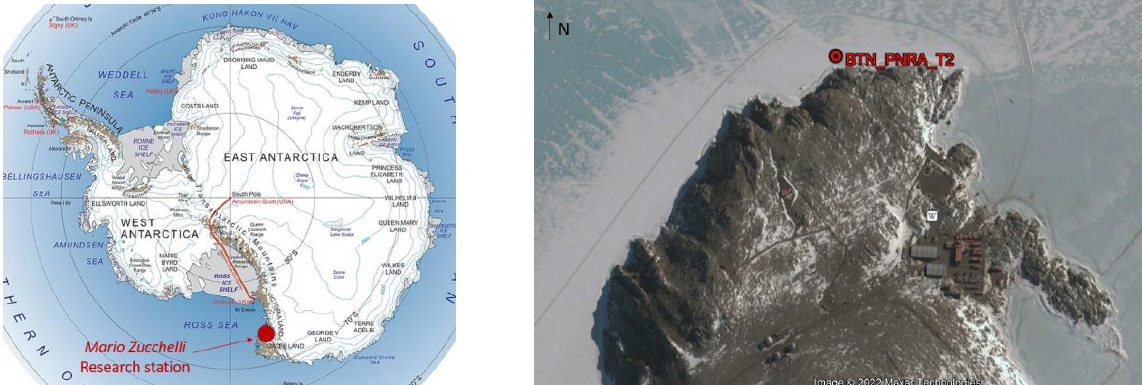
Figure 2. Italian research station “Mario Zucchelli” in Antarctica. Position on the map (left) and satellite view of its location along with the BTN_PNRA_T2 transect position (right).